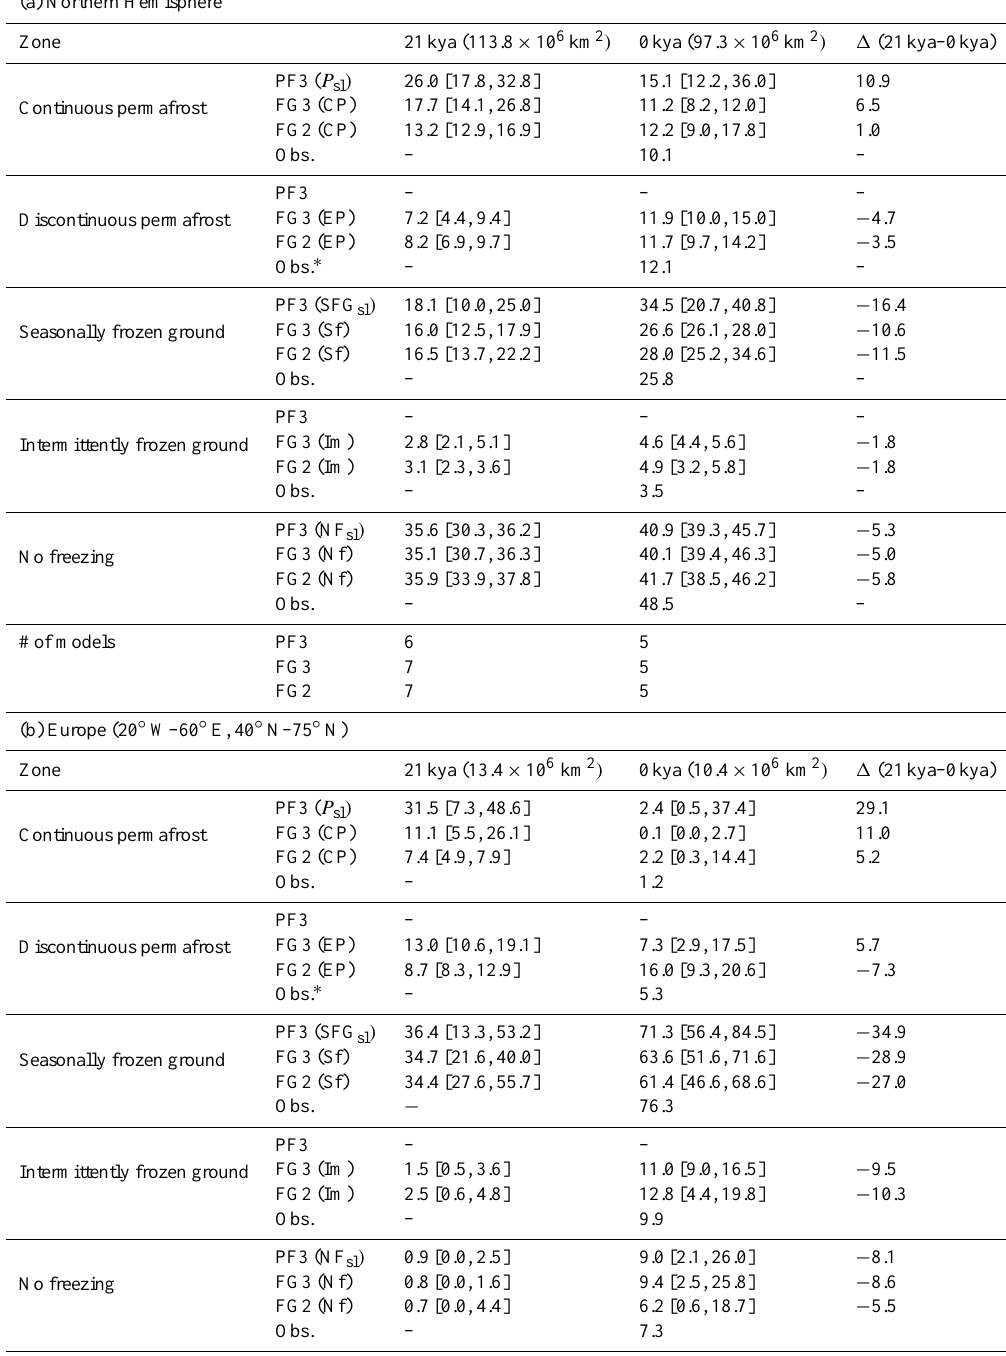
Table 2. Coverage of frozen ground (percentage relative to the land area) in the Northern Hemisphere, simulated by the models in PMIP2 and PMIP3 for the pre-industrial and LGM periods. PF3 denotes T sl -based diagnosis in PMIP3. FG3 and FG2 denote T as -based diagnosis in PMIP3 and PMIP2, respectively. Values are given in median, followed by the minimum and maximum (left and right numbers in the square parenthesis, respectively), and the difference between the two eras. The difference between the two eras is also shown in the rightmost column. Numbers of models used for deriving the statistics for each category are given at the bottom of Table